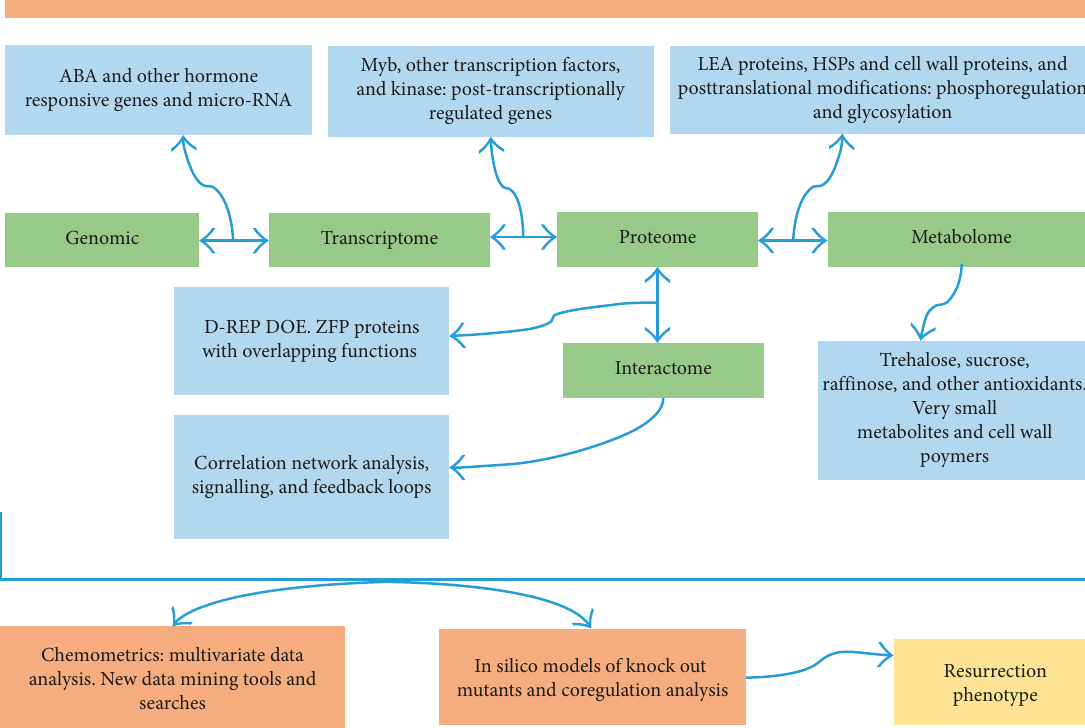
Figure 2: Systems biology framework for DT